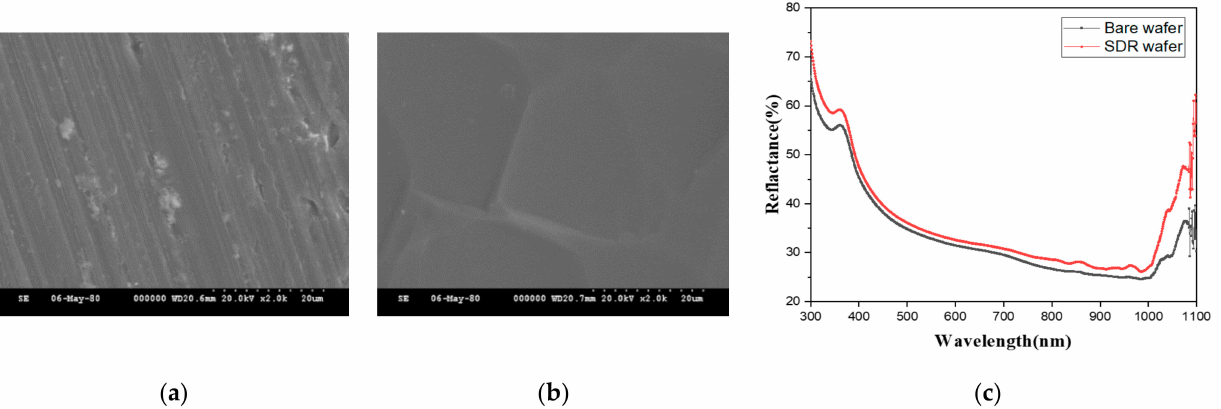
Figure 2. Cross-sectional SEM images of the c-Si wafer before and after the SDR process: ( a ) c-Si wafer before the SDR process, ( b ) c-Si wafer after the SDR process, and ( c ) reflectance of the c-Si wafer before and after the SDR